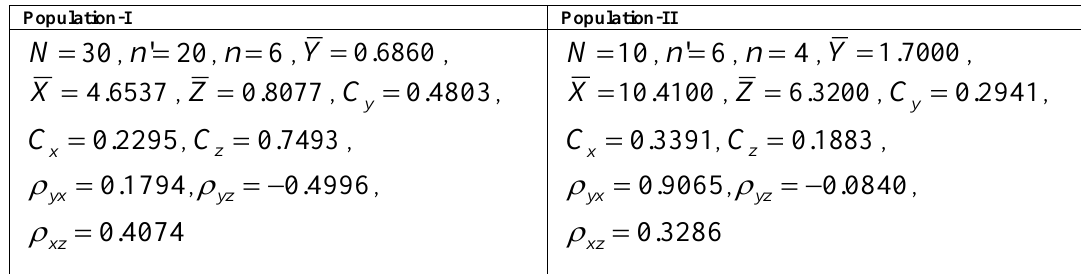
Table 7. Parameters of Population-I and Population-II under consideration